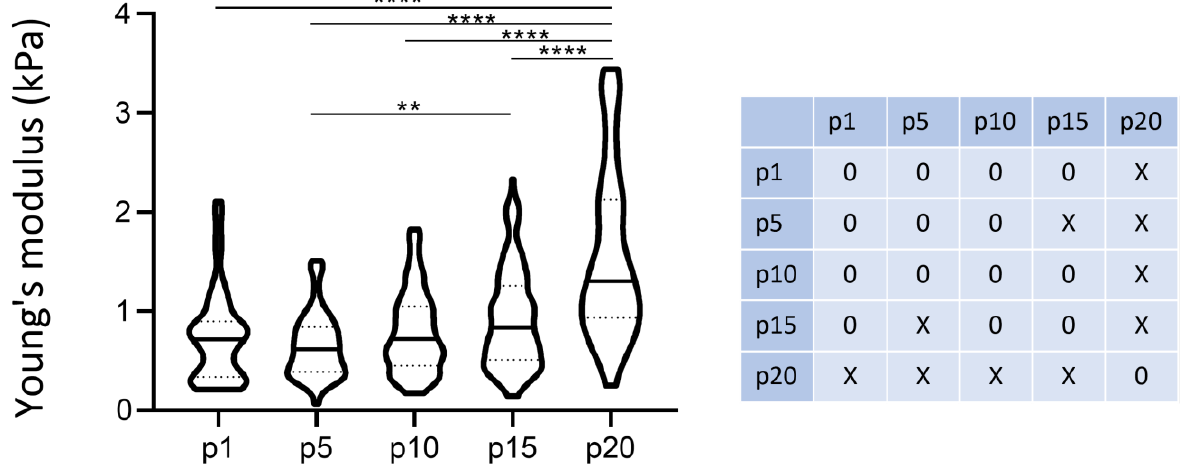
Figure 14. Elastic modulus during cell passages, isolated cells, 300 nm of indentation. The plot shows the distribution of the single-cell Young’s Modulus of fibroblast line 6 during cell passages. The statis- tical analysis was performed through a Kruscal–Wallis test with Dunn’s test for multiple comparisons correction (** p < 0.01; **** p < 0.001). The matrix reports the cases of significant statistical differences.